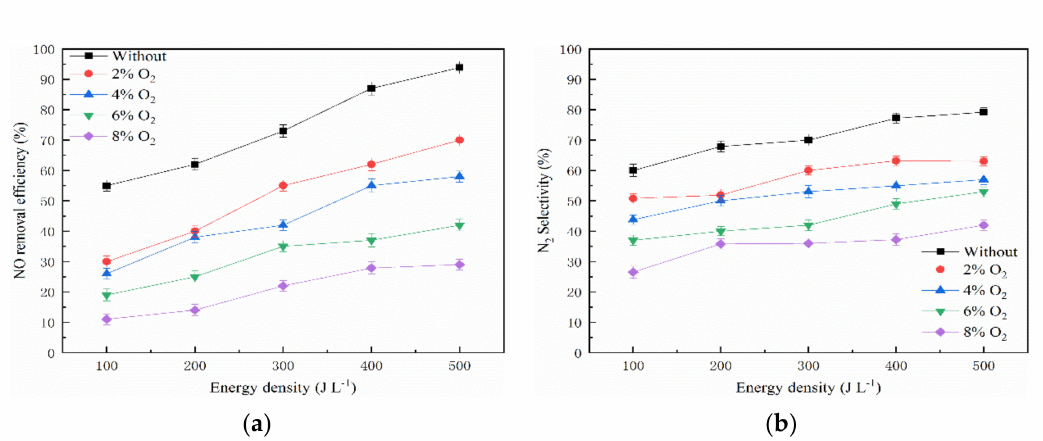
Figure 8. E ff ect of O 2 concentration on NO removal e ffi ciency. ( a ) NO removal e ffi ciency and ( b ) N 2